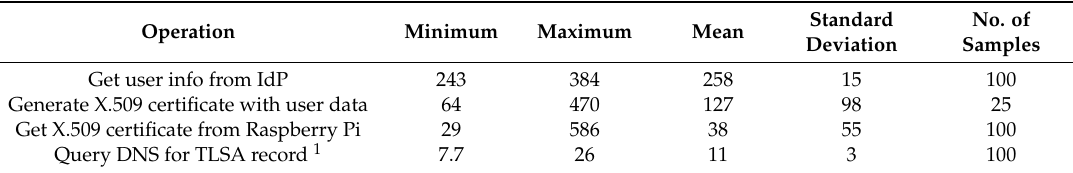
Table 1. Real execution times for selected operations, measured by the calling code [msec]. IdP—identity